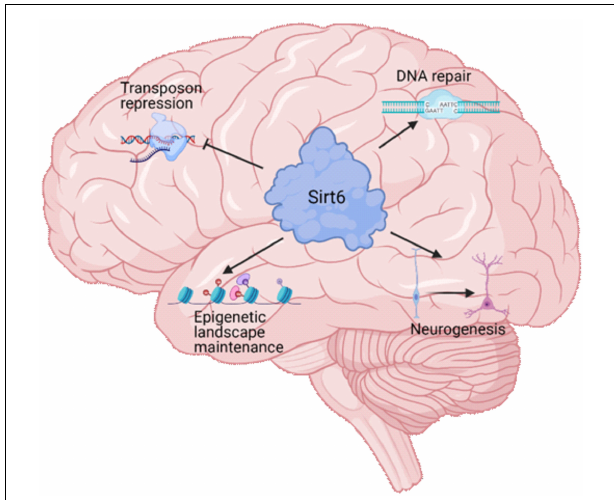
FIGURE 2 | Sirt6 functions in brain physiology. Sirt6 is a multifunctional protein that regulates several cellular processes. During brain development and brain aging, Sirt6 regulates four major processes. The repression of transposable elements, which is necessary for the genome integrity maintenance. The proper function of DNA repair pathways that maintains the genome integrity to promote neuronal survival and function. The epigenetic landscape maintenance through its histone deacetylase activity that allows Sirt6 to repress the expression of specific genes and maintain neuronal identity. The neurogenesis process, which produce the mature neurons during organismal development, and is necessary in adult brains to maintain the function of specific brain